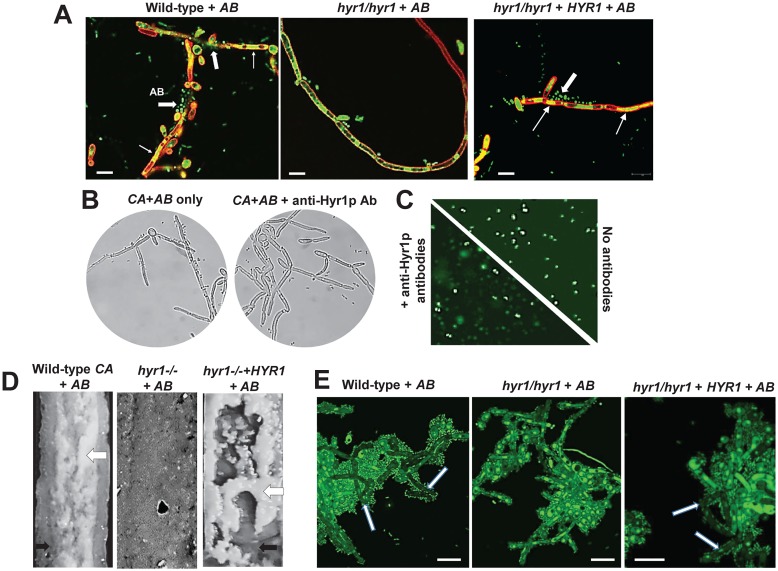
Hyr1 is the C. albicans receptor for A. baumannii binding to hyphae, and attachment of A. baumannii to C. albicans in a flow biofilm model requires Hyr1p.A. baumannii (AB) and C. albicans (CA) cells were allowed to interact physically under hyphae permissive conditions. The cells were stained with ConA (Candida cell wall red) and Syto13 (nuclei green). Acinetobacter binds to (block arrows), and kill wild-type or hyr1/hyr1+HYR1 complemented C. albicans hyphae as observed by degraded fungal nuclei (thin arrows) (A). The bacteria cease to attach to and kill hyphae of C. albicans hyr1/hyr1 mutant strain (A). Anti-Hyr1p-N antibodies abolish attachment of the bacteria to the fungal filaments (B) and inhibit Acinetobacter viability (diminished nuclear staining = dead cells in presence of antibody) (C). Under flow mixed-species biofilm conditions, Acinetobacter binds to wild-type or hyr1/hyr1+HYR1 complemented C. albicans biofilm (black arrow) and forms a thick white layer (white arrow), whereas the bacterial binding is considerably reduced on the C. albicans hyr1/hyr1 mutant cells (D). The extent of A. baumannii binding to C. albicans wild-type, hyr1/hyr1, or hyr1/hyr1+HYR1 complemented strains is microscopically depicted, where the cells are stained with Syto13. Note the dead hyphae in the wild-type and hyr1/hyr1+HYR1 complemented strains but not in the hyr1/hyr1 mutant (white arrows) (E). Bars in A and E are 10 μm.